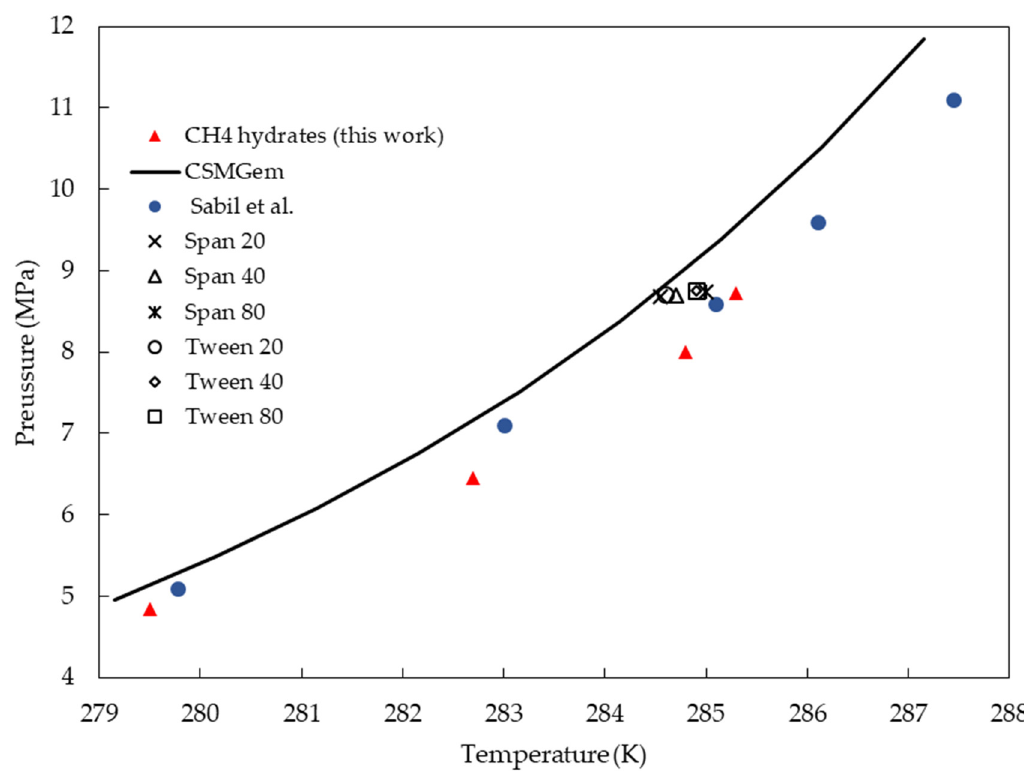
Figure 3. HLVE curve of methane for pure water (CSMGem software, study [27], and this work), 0.03 wt.% SDS, and 2.0% ( v / v ) surfactants.